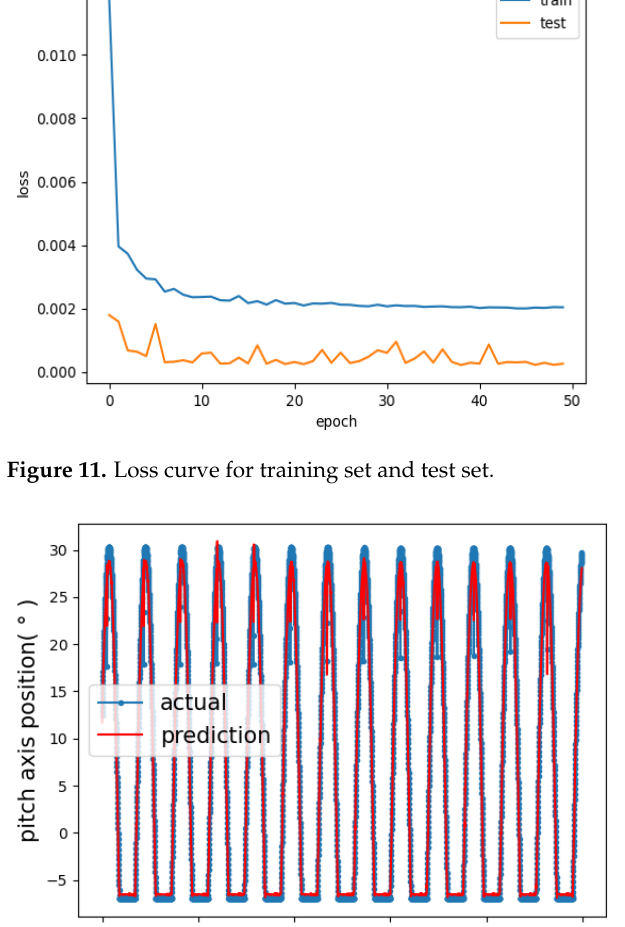
Figure 12. Forecast location map for test set.